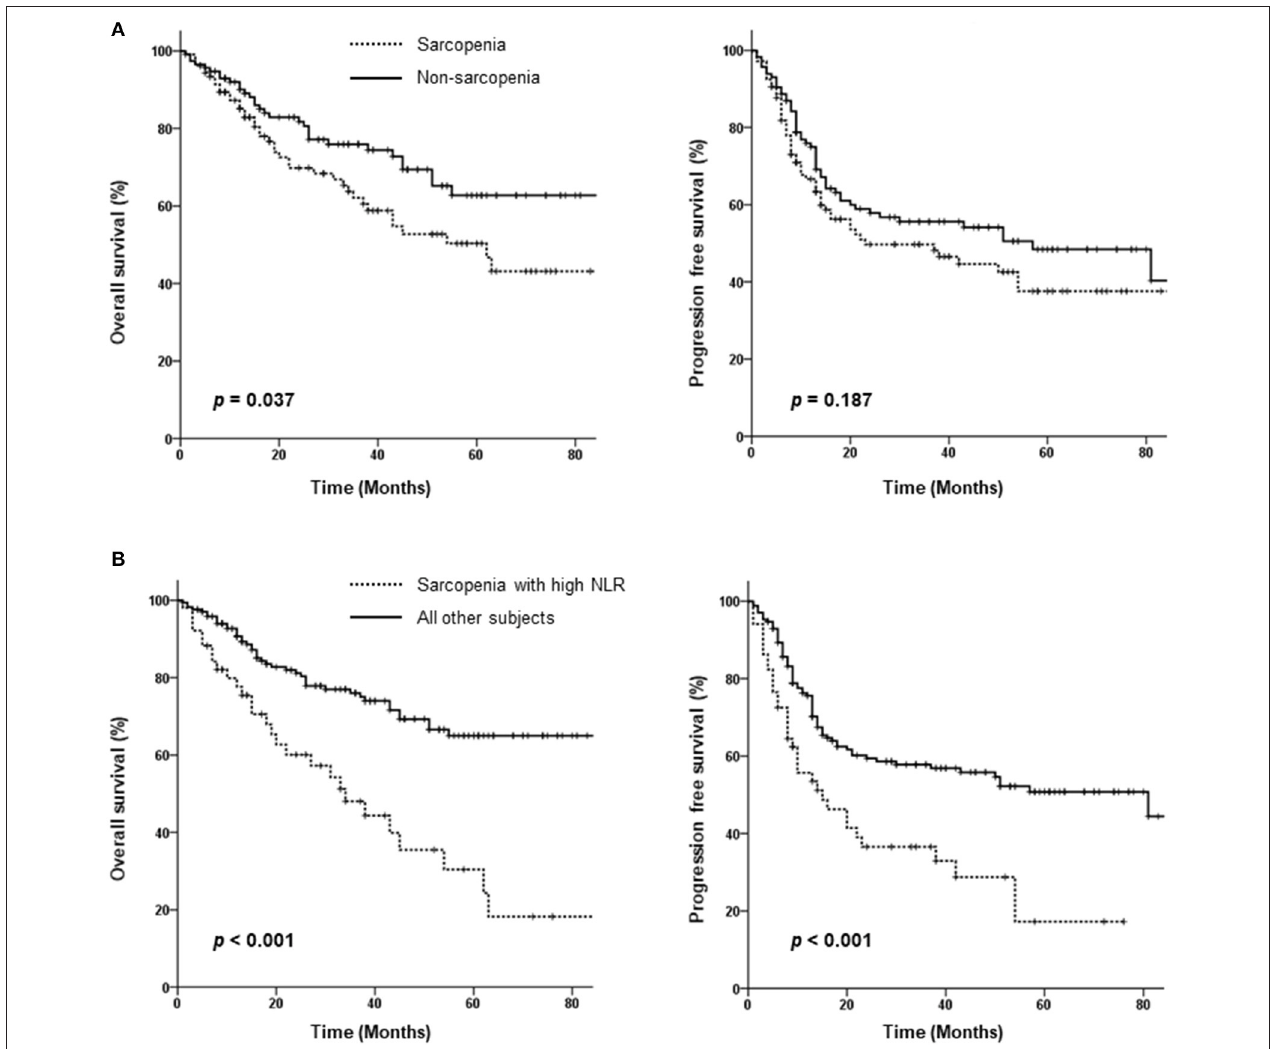
FIGURE 2 | Kaplan-Meier curves comparing overall and progression-free survival between the sarcopenia and non-sarcopenia groups (A) as well as between patients with sarcopenia plus a high neutrophil/lymphocyte ratio (NLR) and those without sarcopenia or a low NLR (B)